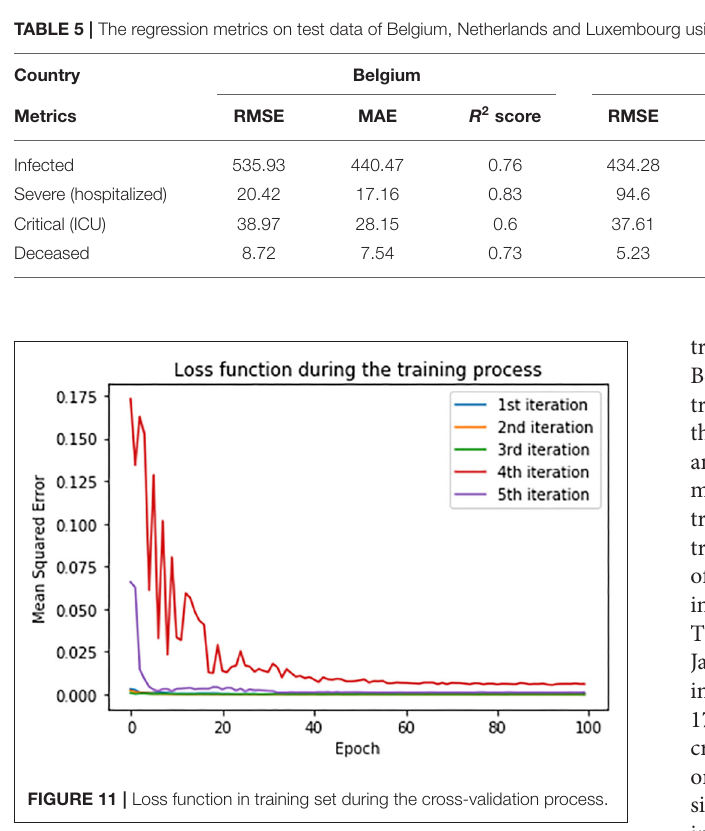
Monte Carlo can be used (84). Future discussion on